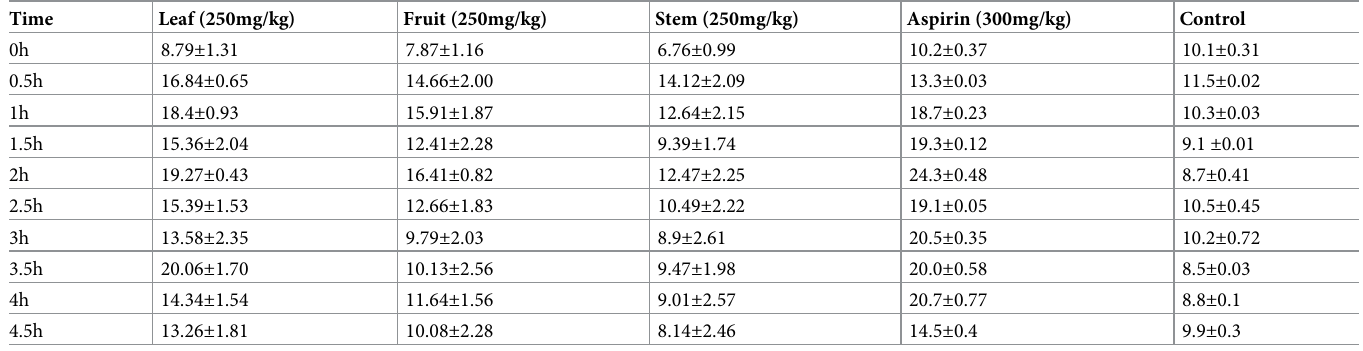
Table 5. The tail flick technique was used to test the analgesic efficacy of a methanolic extract of E . spinosa leaf, fruit, and stem at a concentration of 250 mg/kg. Time